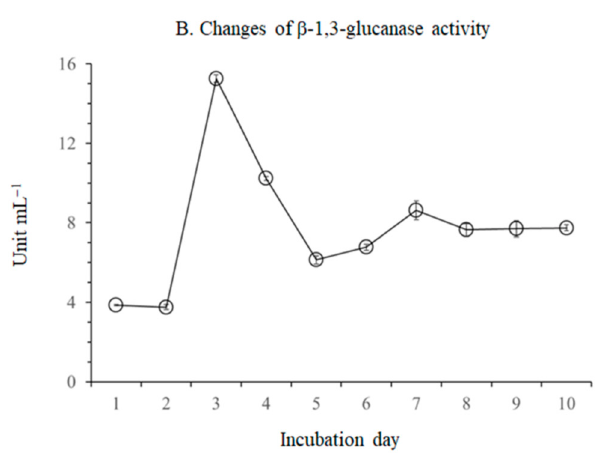
Figure 2. Changes in chitinase activity ( A ) and β -1,3-glucanase activity ( B ) in the culture of B. licheniformis MH48. Error bars represent the standard deviation of three replications.